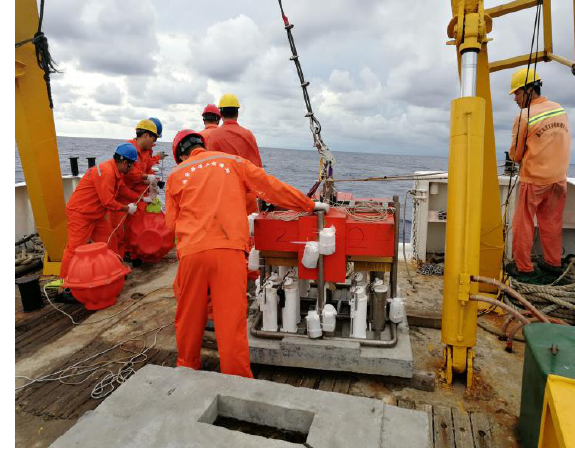
Figure 16. The sea trial deployment of the benthic lander.